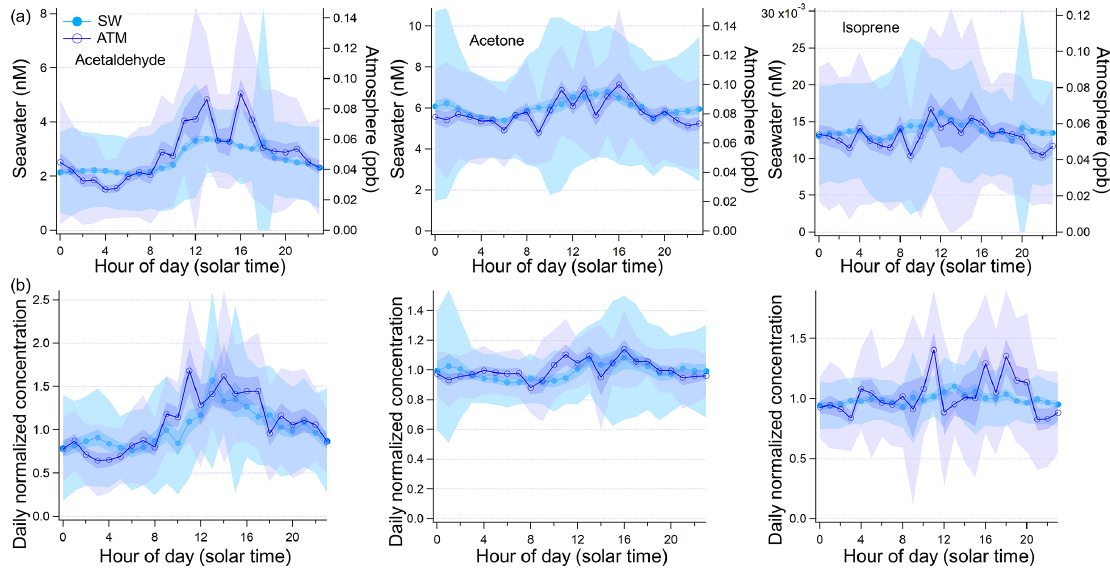
Figure 9. Diurnal changes in seawater and atmospheric concentrations expressed (a) as true 24-hourly averaged concentration and (b) daily normalized concentration where the hourly measured concentration is divided by the average of the 24h that this measurement is part of. Light shaded areas show the standard deviation of each hourly bin, and the darker shaded areas show the standard error of each hourly